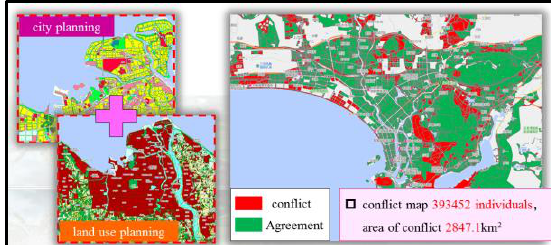
Figure 1. Statistics conflict maps of city planning and land use planning